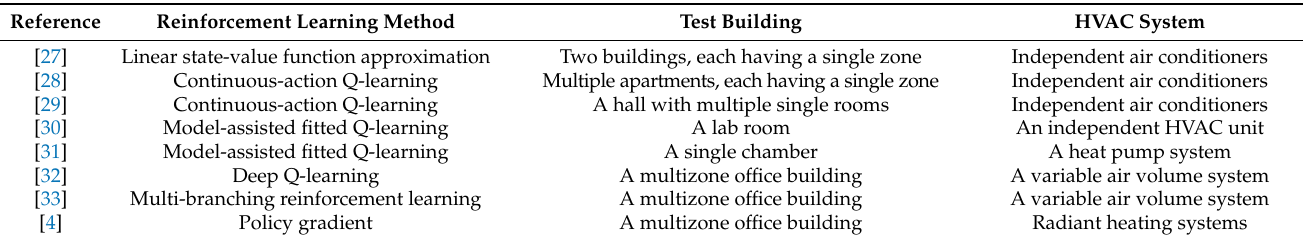
Table 1. An overview of studies focusing on deep reinforcement learning methods for HVAC